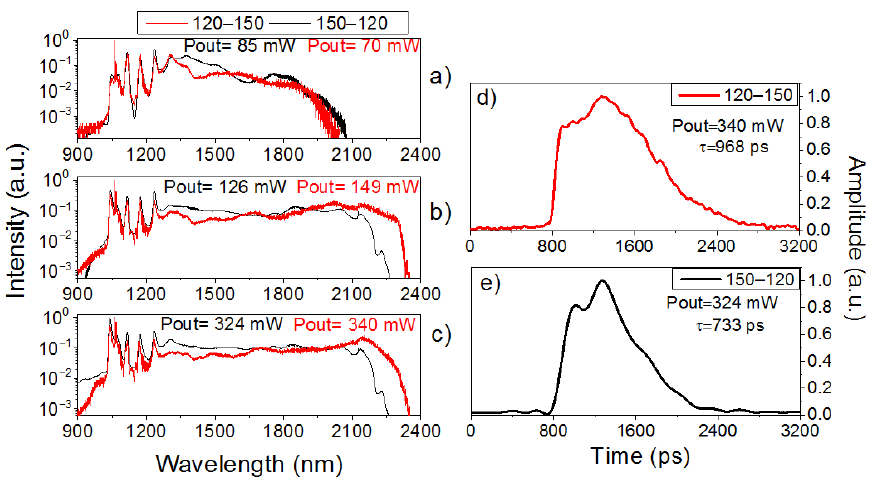
Figure 4. The comparison of the SC spectra obtained at the same amplifier pump powers for the DDF sample in dependence on the propagation direction (( a ) E = 0.149 μ J, ( b ) E = 0.48 μ J, ( c ) E = 0.8 μ J), and envelopes of the obtained pulses ( d , e